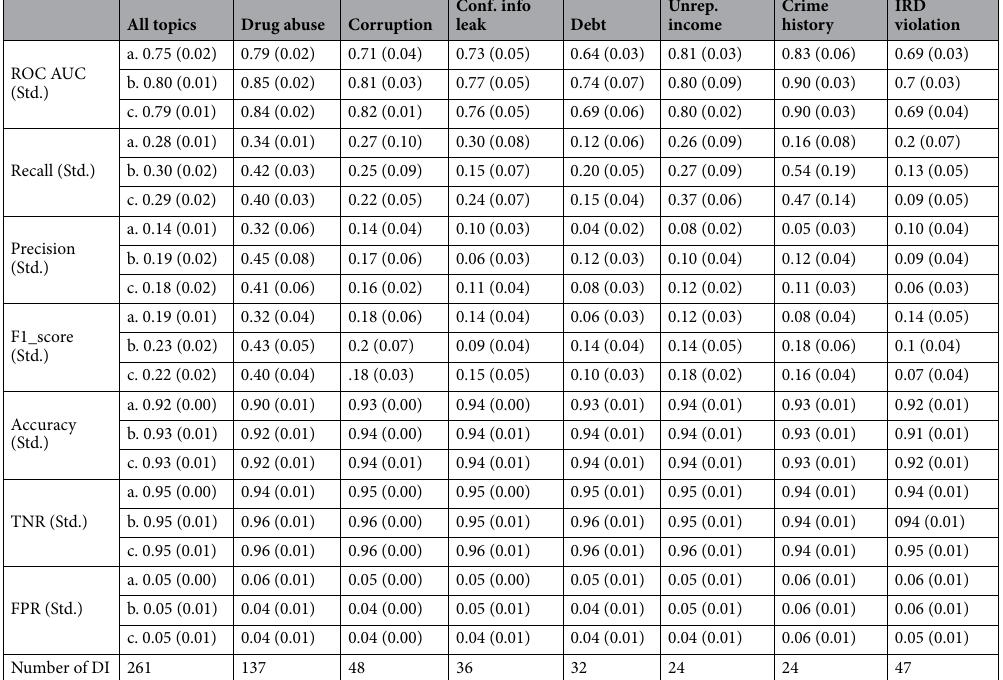
Table 1. Three models inference each of seven screening topics, measured using stratified K-fold cross- validation. (a) Basic model (features based on 10 raw polygraph signals, age and sex of the examinees). (b) Basic model with alternative data. (c) Basic model with job position data.